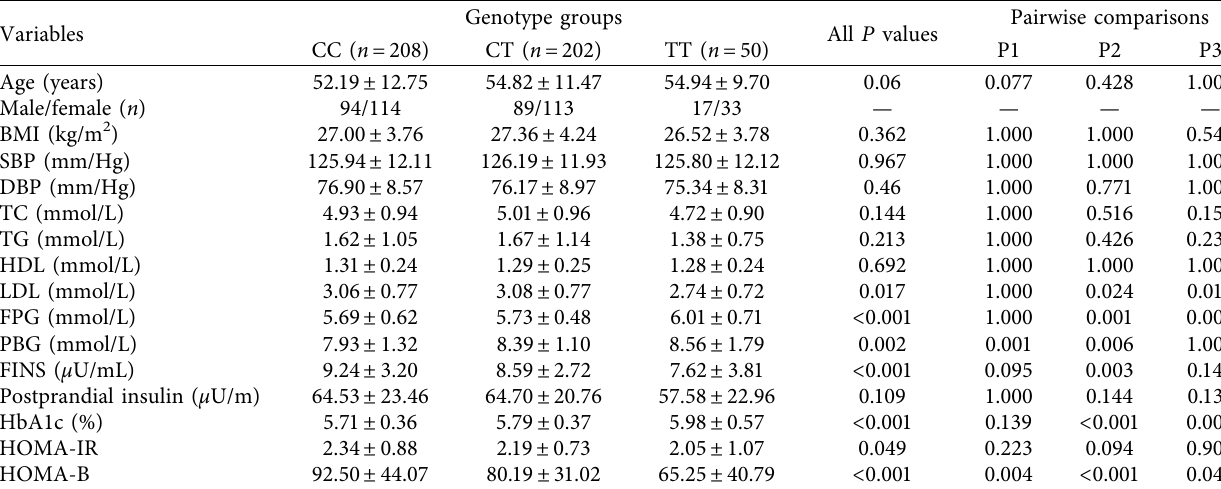
Table 4: Association of the ANGPTL 8 rs2278426 (C/T) polymorphism genotypes with biochemical parameters in the pre-DM group. Variables